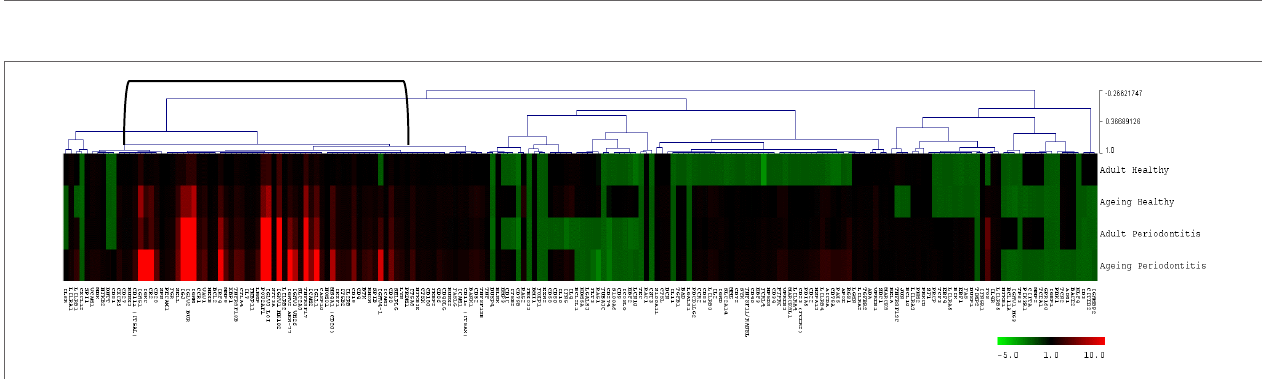
FigUre 4 | heatmap of fold differences in gene expression in adult and aged healthy and periodontitis tissues compared with response levels in healthy gingival tissues from a group of 10 animals 3–7 years of age (approximately 11- to 25-year-old humans) . The bracket identifies a cluster of genes that were highly expressed in adult and aged tissues, particularly